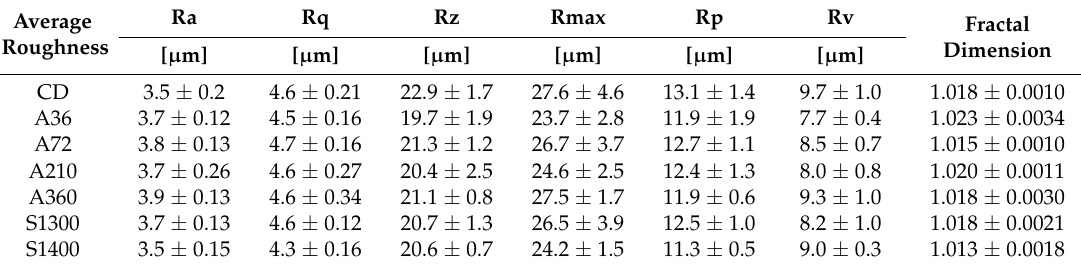
Table 6. Surface roughness test results.